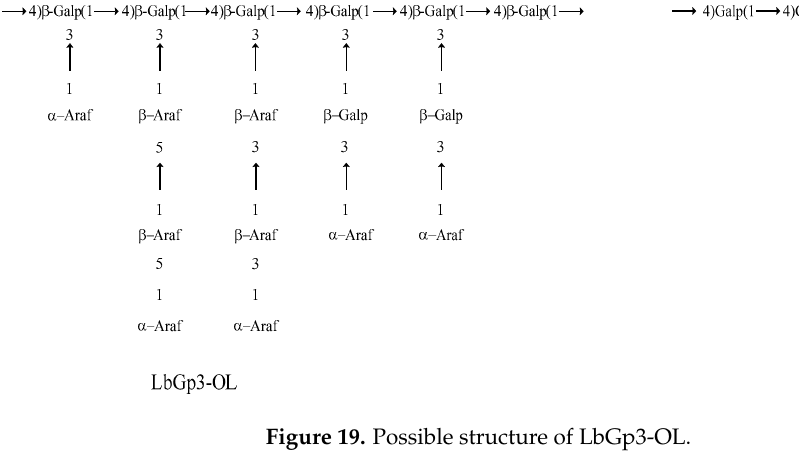
Figure 19. Possible structure of LbGp3-OL.